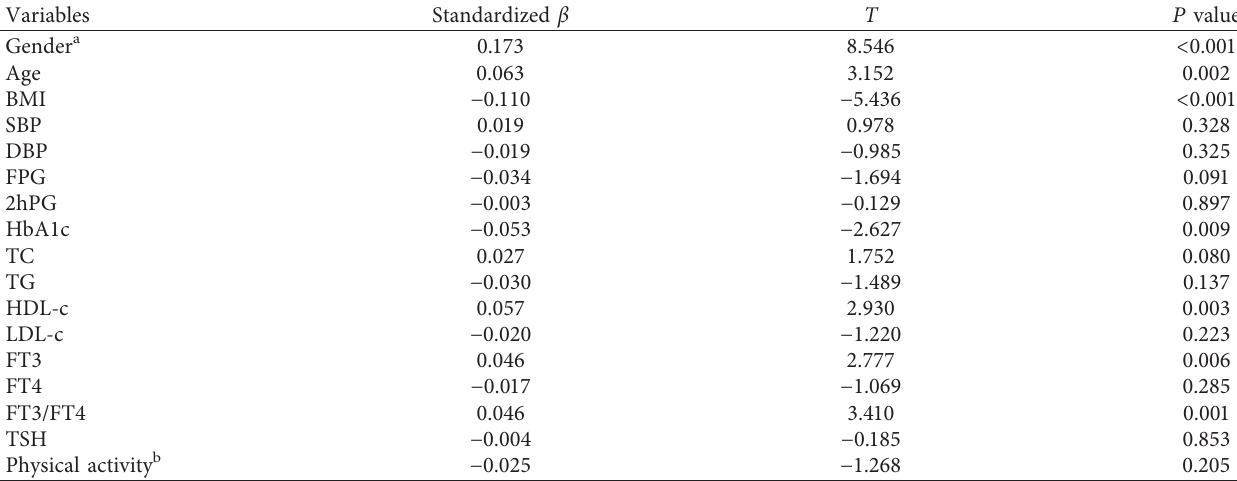
Figure 1: Ridge trace figure for the influencing factors of serum osteocalcin levels. Table 3: Ridge regression analysis on the influencing factors of serum osteocalcin